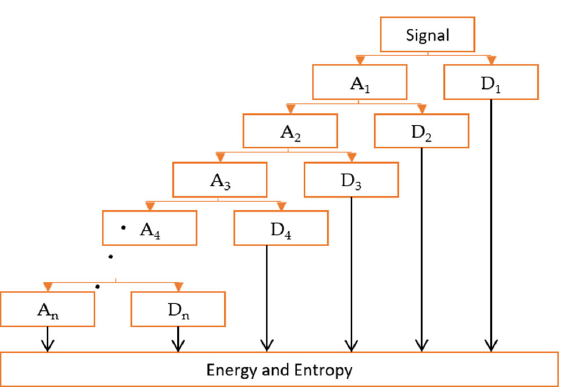
Figure 4. Wavelet feature extraction. A 1 , A 2 , …, A n are approximate coefficients. D 1 , D 2 , …, D n are detailed coefficients. We estimated the energy and entropy of all detailed coefficients and A n .